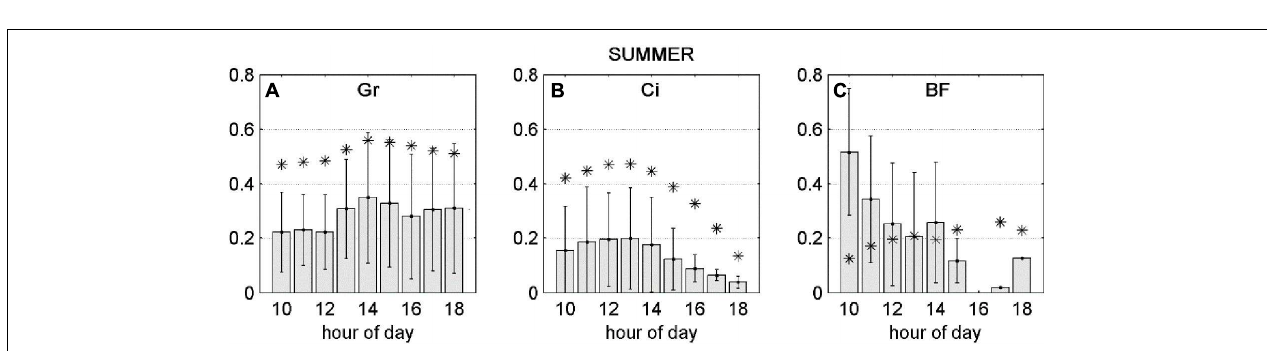
FIGURE 4 | Gray bars: negative fraction of partial derivative of NEP with respect to FO 3st (A–C) or FO 3CUM (D–F) averaged over hours of day, ± standard deviations. Asterisks: FO